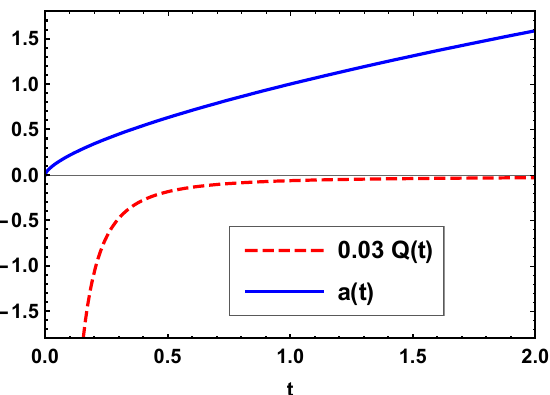
Figure 6. Time evolution of the scale factor (solid line) and the quantum potential (43) (dashed line) for (42), for k = t 0 = 1, in the dust case (w = 0). This solution is analogous with the perfect fluid solutions. For the other relevant cases w = 0 and w = 1/3, the behavior of a ( t ) and Q are very similar, as it can be seen, for instance, from the expression of Q